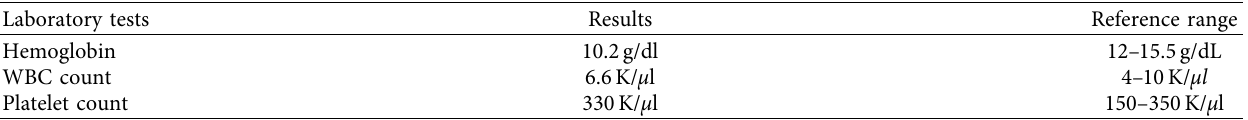
Figure 2: MRI cervical and thoracic spine: (a, b) T2 sagittal and (c) axial view, showing no abnormality. Table 3: Laboratory reports after 8weeks of receiving